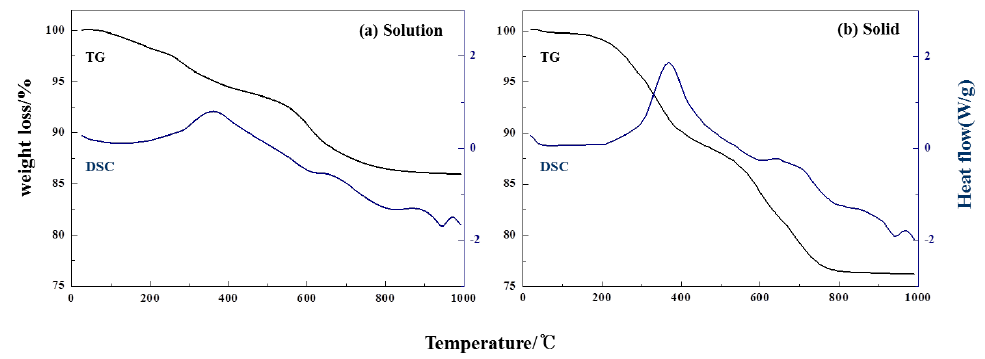
Figure 5. TG-DSC curves for the CDEA – montmorillonites obtained by ( a ) solution and ( b ) solid intercalation processes.